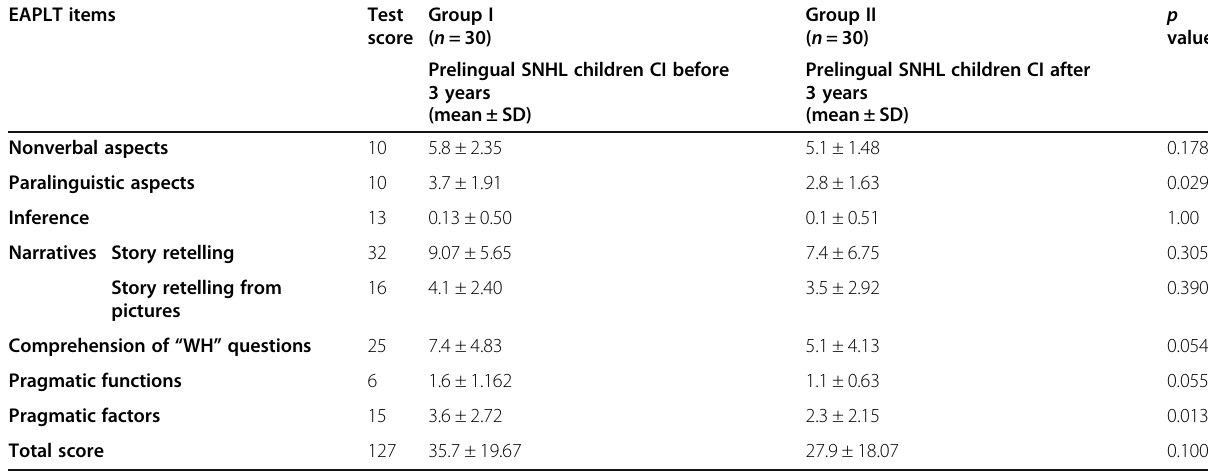
Table 5 Mean and standard deviation (SD) values of the total score and the scores of each item of the Egyptian Arabic pragmatic language test (EAPLT) language ages by the Modified Pre-school Language Scale-4, Arabic version and comparison between their values among the 2 studied